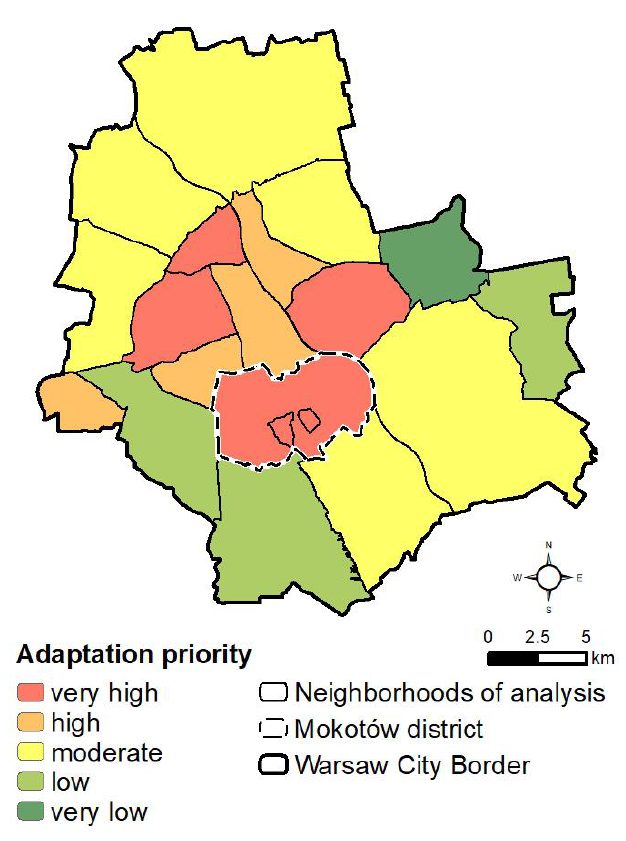
Figure 1. Adaptation priority of Warsaw’s districts.